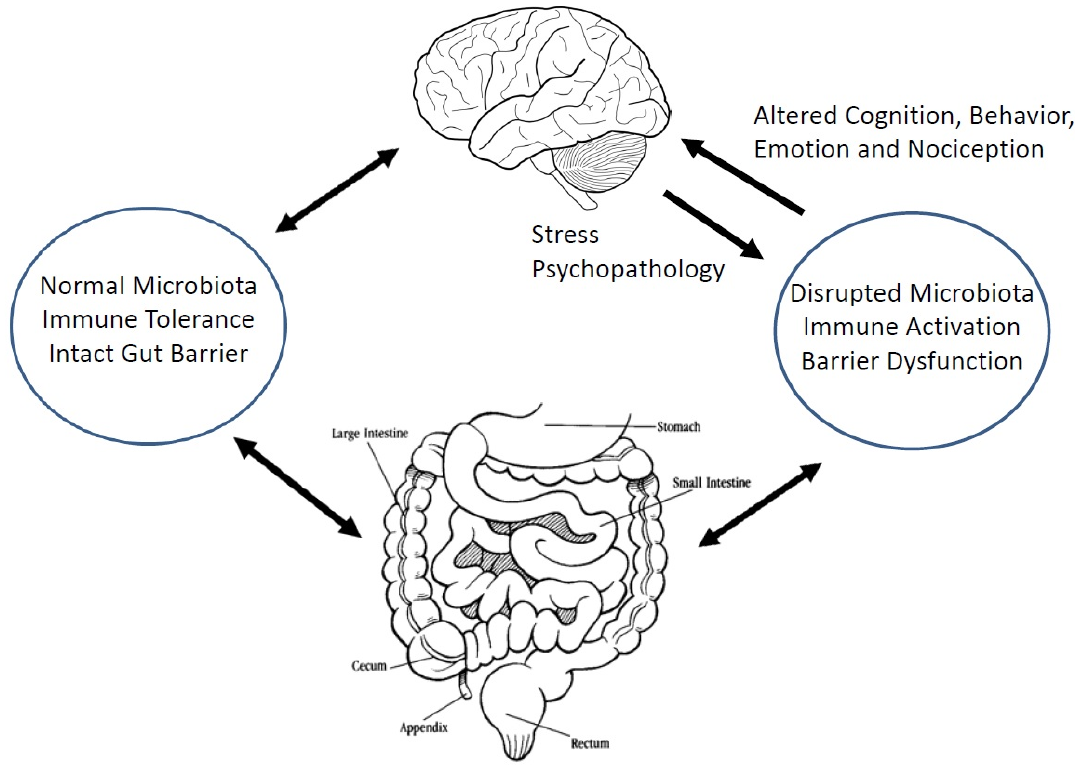
Figure 1. A schematic representation of the microbiota ‐ gut ‐ brain axis. An abnormal microbiota associated with a disrupted gut barrier and the activation of the mucosal immune system leads to the release of inflammatory mediators and other neuroactive molecules into the systemic circulation from where they reach the brain and result in changes in cognition and behavior. Alternately, central stimuli, such as stress, can disrupt mucosal immunity, the gut microbiota and gut barrier function and lead to gut dysfunction. Note: bidirectional nature of the relationships between the gut, the microbiota and the brain.